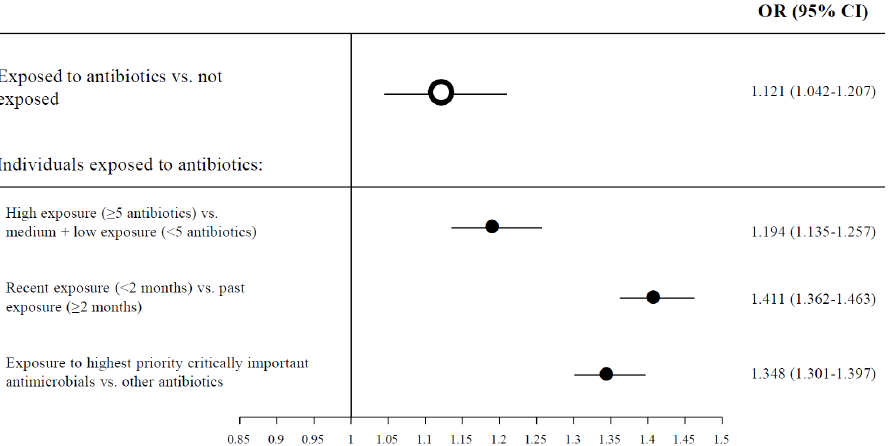
Figure 2. Forest plot showing adjusted odds ratios of the association between different antibiotic exposures and the com- posite severity endpoint of COVID-19. Patients with previous exposure to antibiotics had a non-significant increased risk of pneumonia (OR: 1.18; 95% CI: 0.81–1.74), and significant increased risk of hospital admis- sion (OR: 1.14; 95% CI: 1.02–1.27) (Supplementary Table S3). The risk of death was signif- icantly higher among individuals taking five or more antibiotic courses in the previous two years compared to those with a lower exposure (OR, 1.44; 95% CI: 1.33–1.55). Recent antibiotic use was associated with an increased probability of pneumonia and hospitali- zation, but a lower death rate. Notwithstanding, the use of HPCIAs was significantly as- sociated with a higher risk of both pneumonia, hospital admission and death (Supplemen- tary Table S3). 3. Discussion Catalonia was hard-hit by the first wave of the COVID-19 pandemic and it constitutes a suitable region to investigate risk factors of COVID-19 severity. Our study assessed the composite endpoint of COVID-19 severity combining pneumonia, hospital admission and/or death in two cohorts of patients—those exposed to antibiotics in the previous two years and those not exposed. The results of our study reveal that there is a correlation between previous antibiotic exposure and severity. Multivariable analysis showed that most of this effect was due to underlying chronic diseases and the concomitant use of other medications, but the effect continued being statistically significant after adjustment for potential confounders. In addition, as hypothesized, this correlation between previous exposure and COVID-19 severity was strongest among individuals with high antibiotic exposure, recent exposure, and exposure to HPCIA. To our knowledge, this is the first population-based study in our setting to assess the relationship between previous exposure to antibiotics and COVID-19 severity. The strengths of this study are the large number of patients included, complete sociodemo- graphic data and real-world data. Our data are representative of the Catalan general pop- ulation as stated by other previous studies [18]. This study also has some limitations in- herent to electronic database studies, such as incompleteness, potential confounders, non- randomized data, and possible selection biases. Furthermore, the real exposure of